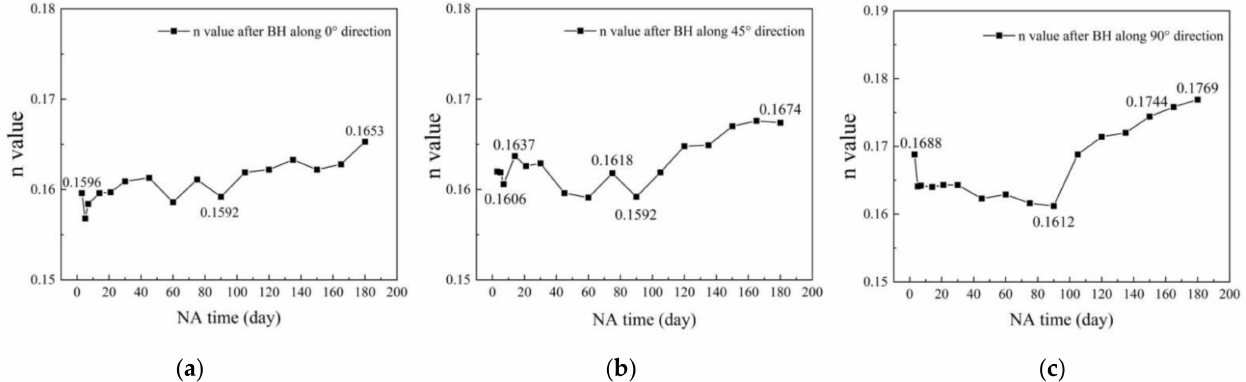
Figure 15. The change curve of n value after bake hardening along 0 ◦ ( a ), 45 ◦ ( b ), and 90 ◦ ( c )